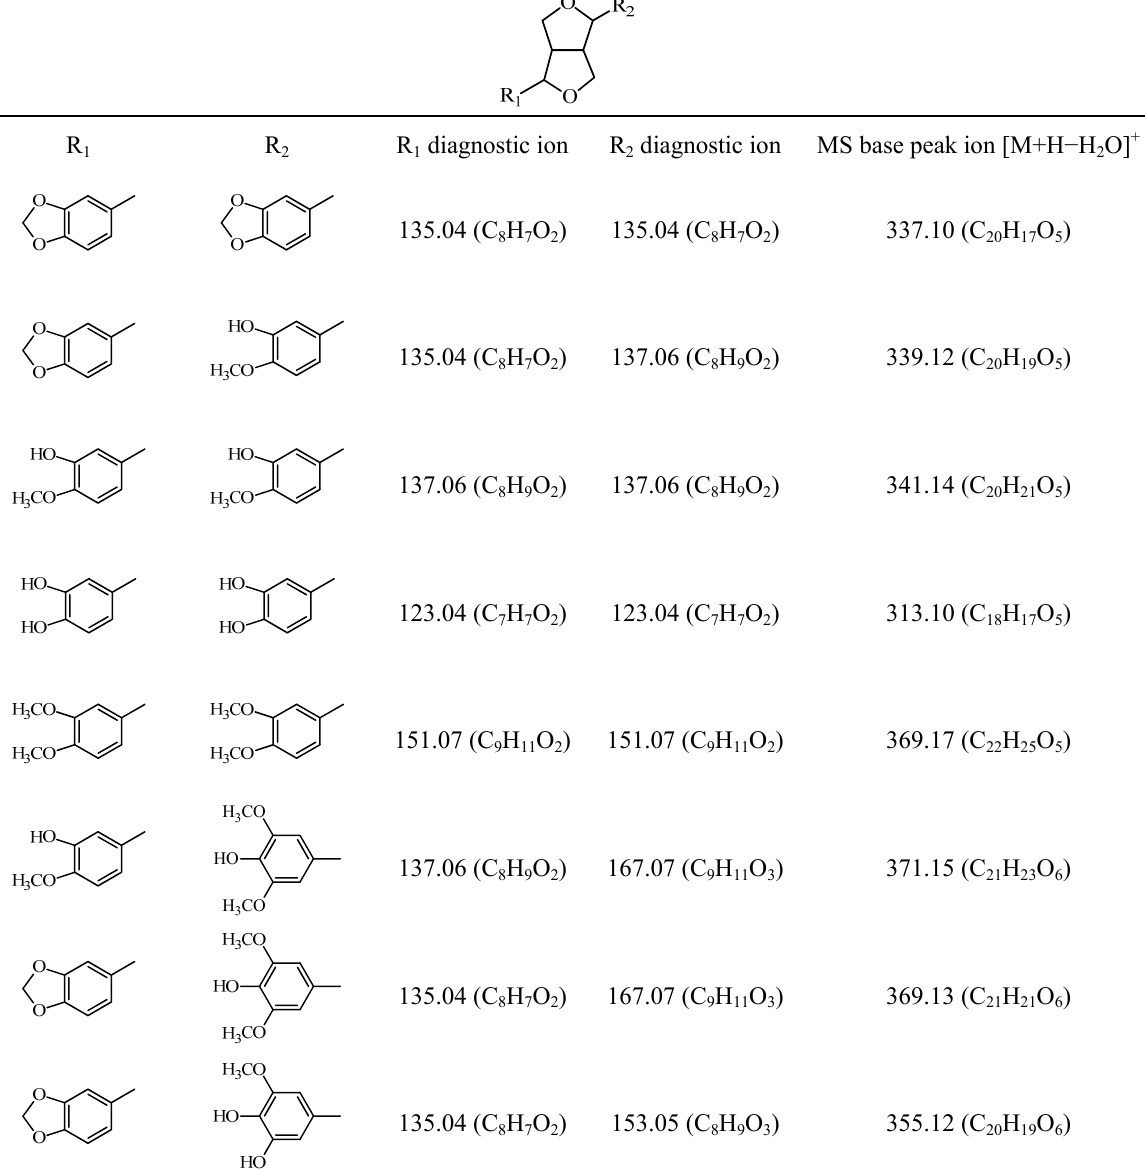
Table 3. The structure skeleton, common substituent groups and diagnostic positive APCI-MS n fragment ions of furofuran